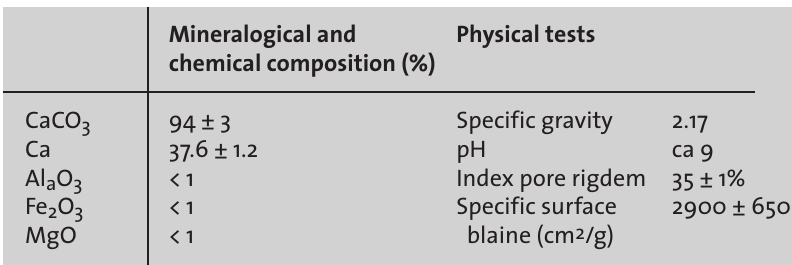
Table 3: Mineralogical, chemical and physical properties of the used fines.